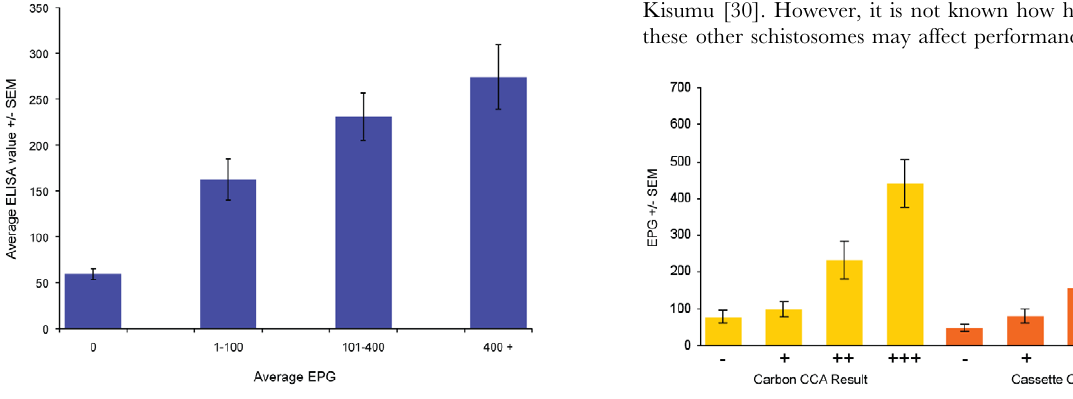
Figure 4. CCA assay band intensity correlates with level of schistosome infection. The intensity of the results of the CCA assays are associated with schistosome infection intensity (p , 0.0001, Kruskal- Wallis ANOVA), as determined by the Kato-Katz method